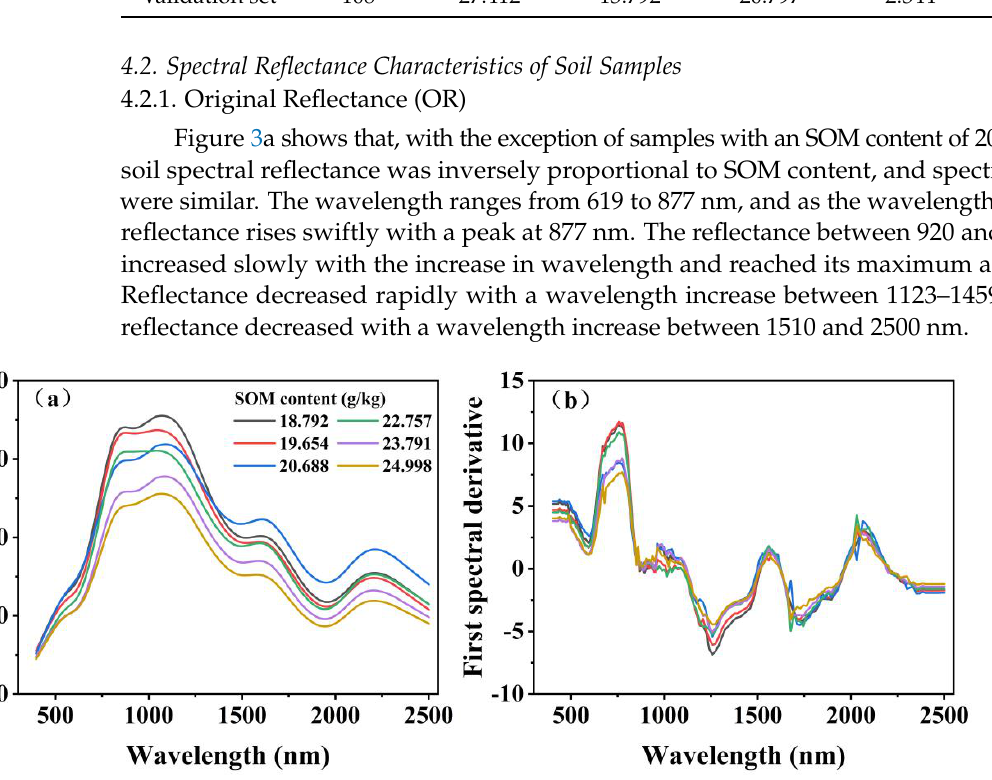
Figure 3. Soil reflectance curves with different soil organic matter content (( a ) is OR; ( b ) is FDR).